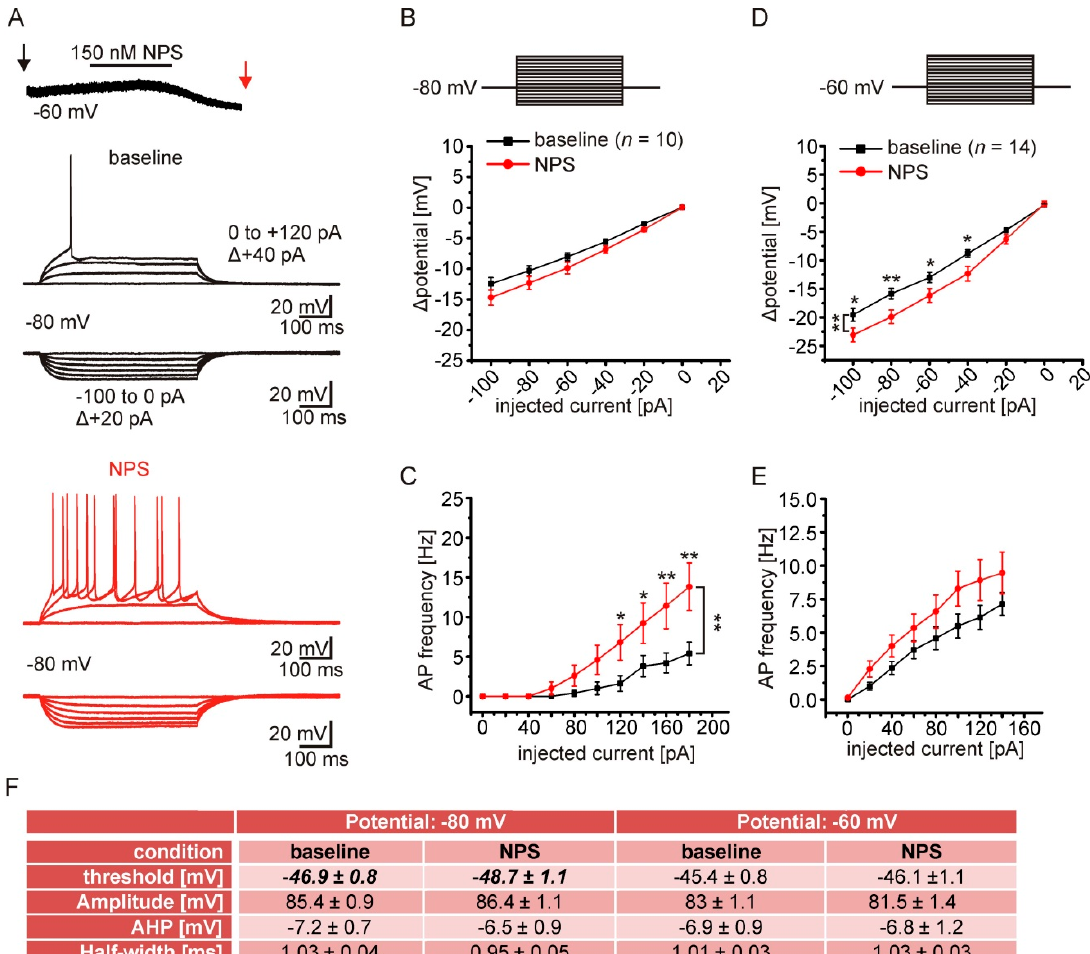
Figure 6. NPSR1-activation enhances action potential generation in aBA PNs. ( A ) Example of the experimental procedure. Current-clamp recordings were done during baseline conditions (black arrow) and during maximal NPS effect (red arrow). The onset of the NPS effect was monitored in voltage-clamp at − 60 mV. In current-clamp, hyper- and depolarizing current injections (first: − 100 pA; Δ + 20 pA; 500 ms duration) were applied from a membrane potential of either − 60 mV or − 80 mV. Example traces depict recordings from − 80 mV during baseline (black) or in the presence of NPS (red). ( B ) Analysis of passive membrane properties during current injections ( − 100 to + 50 pA) from a membrane potential of − 80 mV. No significant changes of Δ potential in response to current injections were observed in the presence of NPS. ( C ) Frequency of evoked action potentials is enhanced in the presence of NPS compared to baseline. ( D ) At − 60 mV hyperpolarizing current injections resulted in enhanced ∆ potential in the presence of NPS. ( E ) At − 60 mV depolarizing current injections did not change the discharge pattern significantly. ( F ) Analysis of action potential characteristics during baseline conditions and in the presence of NPS during both recording conditions. * p < 0.05; ** p <